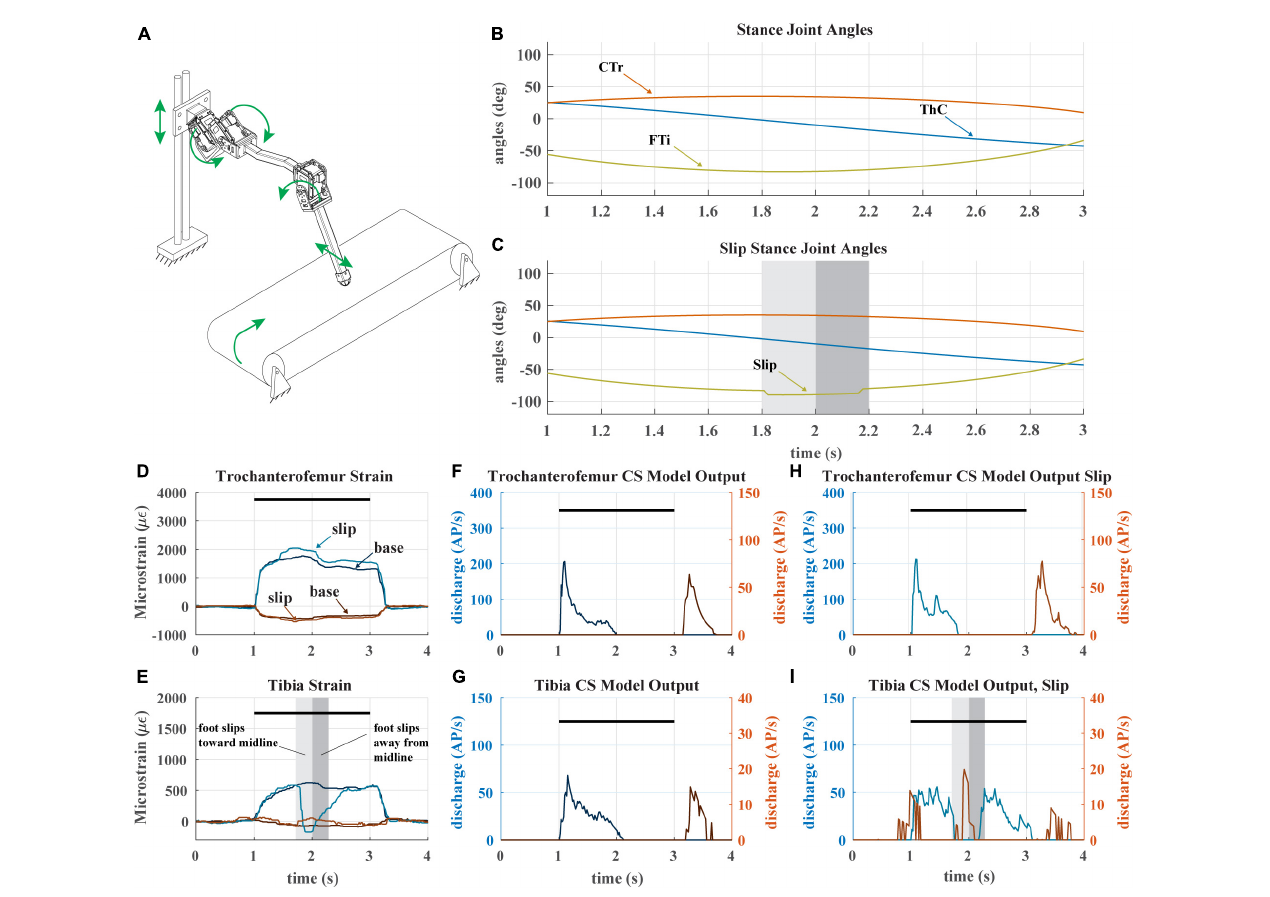
FIGURE8 (A) Diagram of robotic leg configuration. Green arrows show type and direction of movement for the servomotors, linear guide, and treadmill. A green arrow shows the direction the tibia is forced to slip in. (B) Stance joint angles of servomotors in baseline configuration (no slip condition) (C) Stance joint angles of servomotors with added slip condition as seen in middle of stance. Shaded bars indicate duration and location of slip condition. (D) The raw trochanterofemur strain of individual steps in baseline and slip configurations. Positive changes in values indicate compression in that direction; negative changes in values indicate tension in that direction. The axial is indicated in shades of blue and transverse indicated in shades of red. The black bars indicate stance phase. (E) The raw tibia strain of individual steps in baseline and slip configurations. (F) The model CS output of the trochanterofemur in baseline configuration. (G) The model CS output of the tibia in the baseline configuration. (H) The model CS outputs of the trochanterofemur in slip configuration. (I) The model CS outputs of the tibia in the slip